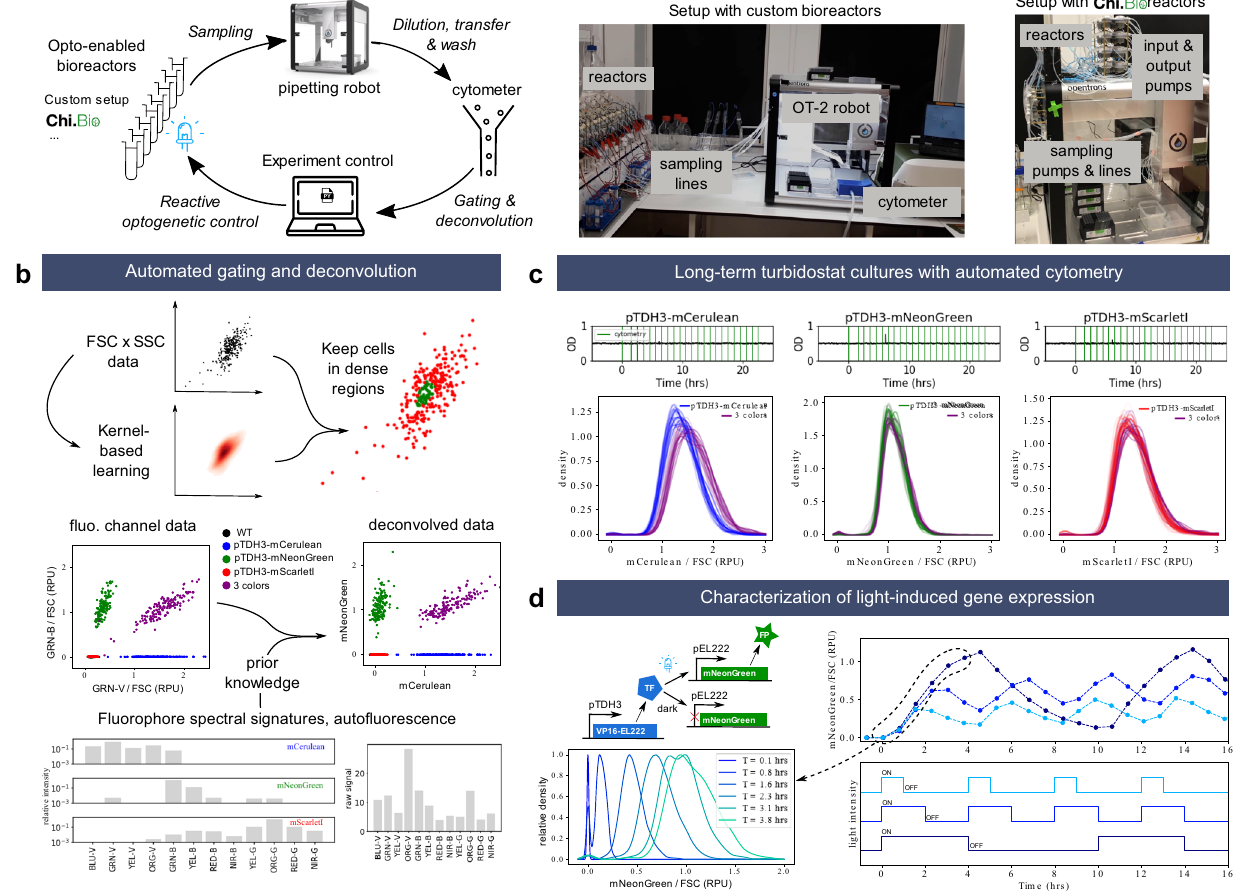
Fig. 2 ReacSight-based assembly of an automated platform enabling reactive optogenetic control and single-cell resolved characterization of yeast continuous cultures. a Platform overview. The Opentrons OT-2 pipetting robot is used to connect optogenetic-ready multi-bioreactors to a benchtop cytometer (Guava EasyCyte 14HT, Luminex). The robot is used to dilute fresh culture samples in the cytometer input plate and to wash it between time points. The ‘ clicking ’ Python library pyautogui is used to create the cytometer instrument control API. Custom algorithms were developed and implemented in Python to automatically gate and deconvolve cytometry data on the fl y. Two versions of the platform were assembled, using either a custom bioreactor setup (left photo) or Chi.Bio reactors 4 (right photo). b Description of the gating and deconvolution algorithm. As an example, deconvolution between the overlapping fl uorophores mCerulean and mNeonGreen are shown. c Stability of single-cell gene expression distributions over many generations. Strains constitutively expressing either mCerulean, mNeonGreen or mScarlet-I alone or altogether ( ‘ 3-colors ’ strain) from the transcriptional units driven by the pTDH3 promoter and integrated in the chromosome were grown in turbidostat mode (OD setpoint = 0.5, upper plots) and cytometry was acquired hourly (vertical green lines). Distributions (smoothed via Gaussian kernel density estimation) of fl uorophore levels (after gating, deconvolution, and normalization by the forward scatter, FSC) for all time points are plotted together with different color shades (bottom). RPU: relative promoter units (see Methods). The OD data for the ‘ 3-colors ’ are not shown for simplicity and are similar to the others. d Characterization of a light-driven gene expression circuit based on the EL222 system 17 . Three different ON – OFF blue light temporal pro fi les were applied (bottom) and cytometry was acquired every 45 min. The median of gated, deconvolved, FSC-normalized data is shown (top). All bioreactor experiments presented in this fi gure were performed in parallel, the same day,